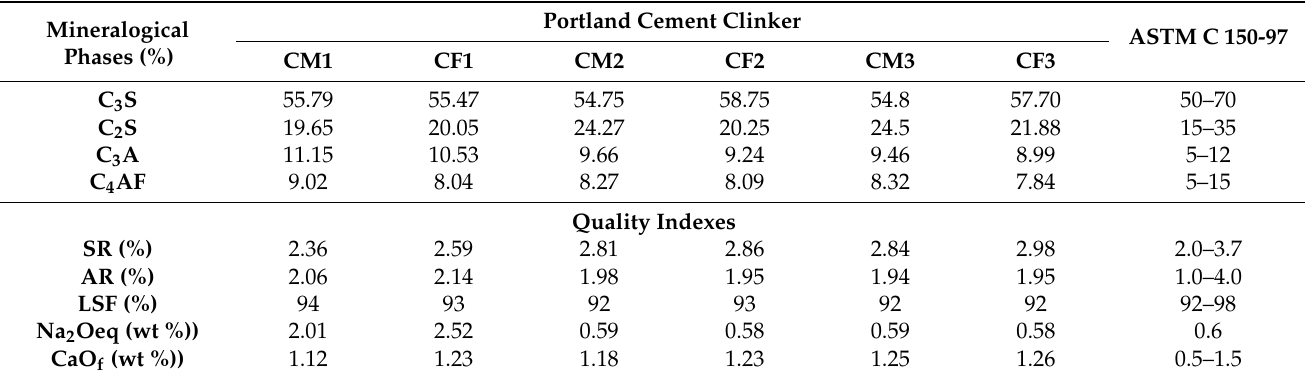
Table 5. Mineralogical composition of the prepared cement